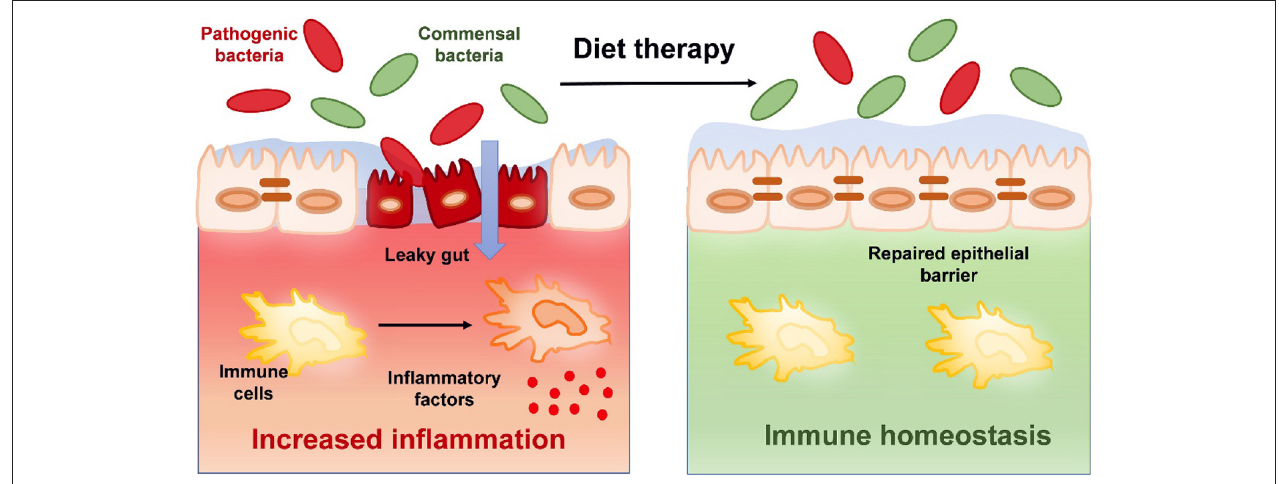
FIGURE 1 | The therapeutic effects of diet on intestinal barrier function and immune homeostasis in